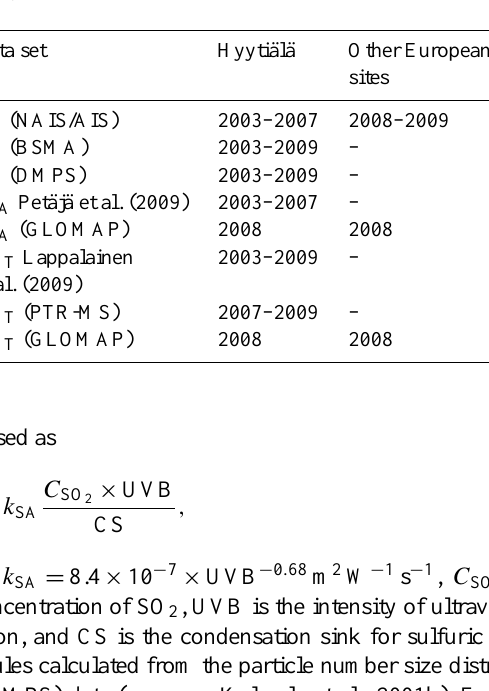
Table 2. The data sets (monthly medians) used for fitting Eq. 1. Nanoparticle diameter growth rates (GR), concentrations of sul- furic acid ( C SA ) and monoterpenes ( C MT ) . The GR data sets are the same as those used by Yli-Juuti et al. (2011) and Manninen et al. (2010). See text for